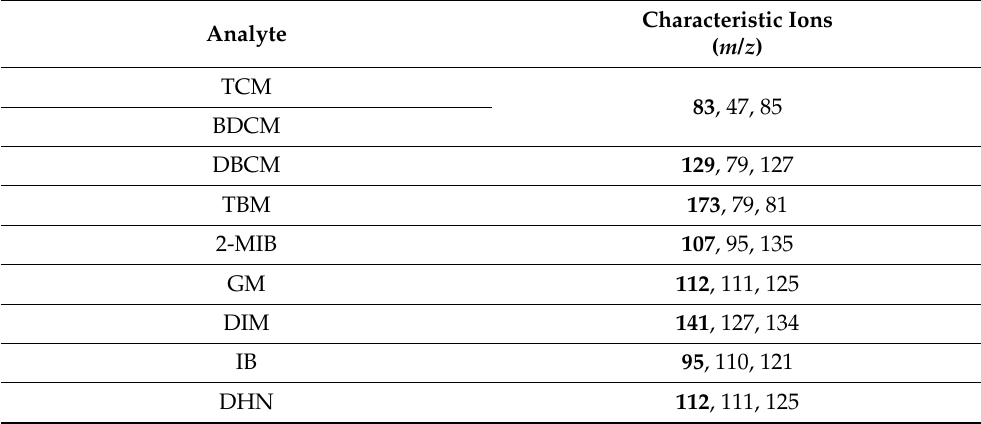
Table 3. Characteristic ions ( m / z ) of THMs, T&Os, and internal standards studied. m/z ion marked in bold was used for quantitative